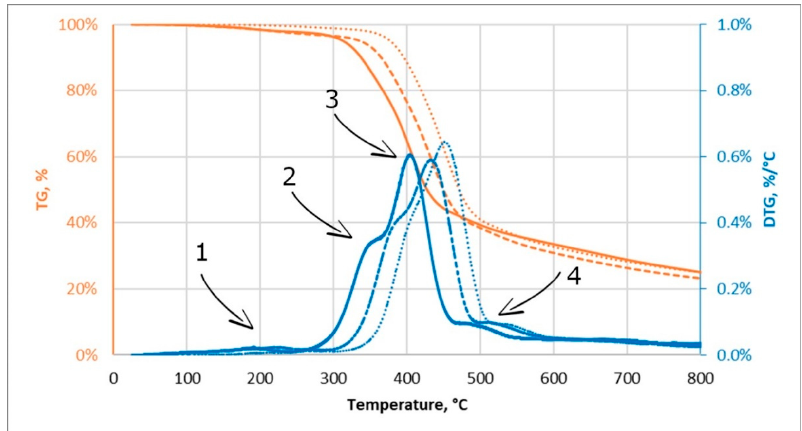
Figure 15. Results of thermogravimetric analysis (TGA) / derivative curve (DTG) analysis Heating rates are presented by di ff erent lines. Solid line—2.5 ◦ C · min − 1 , dashed line—5.0 ◦ C · min − 1 , dotted line— 7.5 ◦ C · min − 1 . 1—bound water, 2—hemicellulose, 3—cellulose,